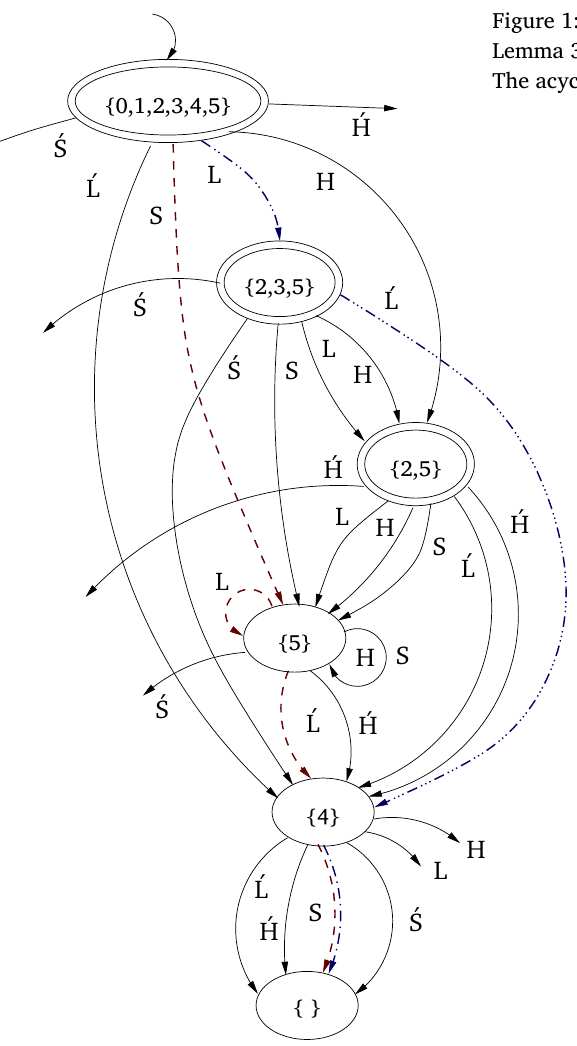
Figure 1: Lemma 3: The cyclic path is labelled S ( L ) (cid:3) ´LS . The acyclic path is labelled